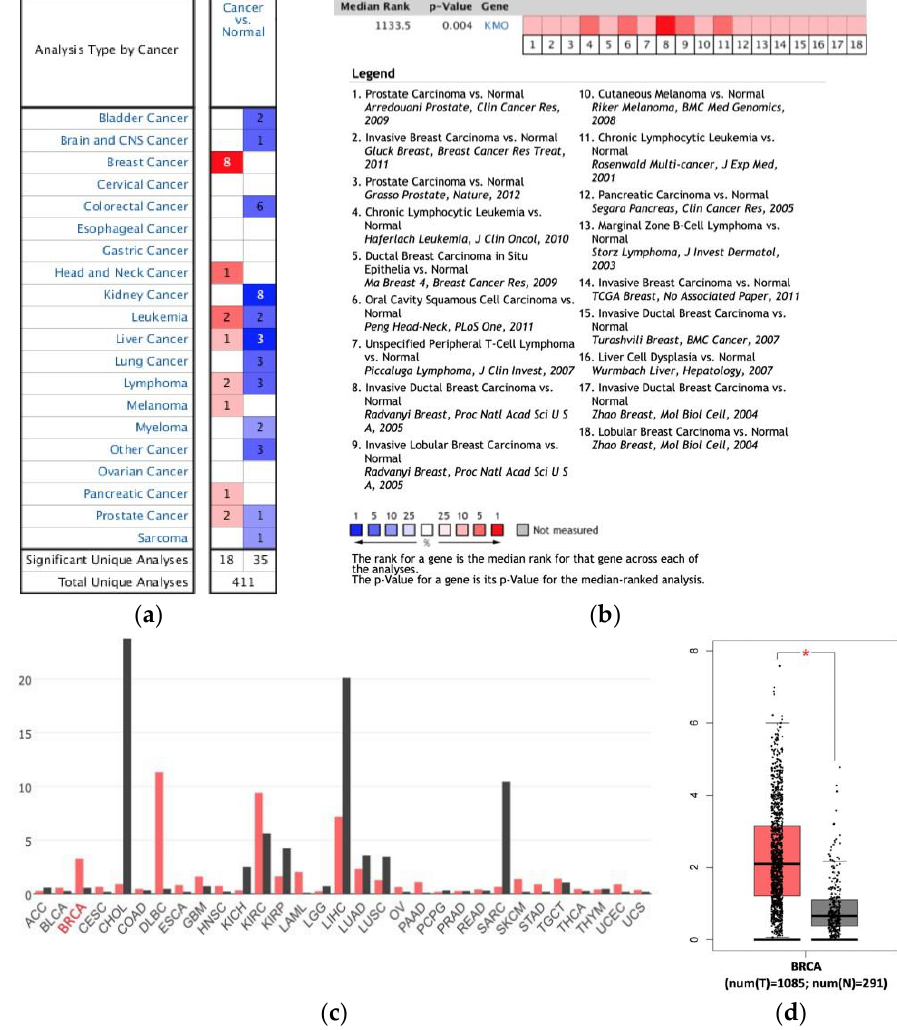
Figure 1. The transcription levels of KMO in human breast cancer. ( a ) The number of datasets with statistically significant KMO mRNA (cancer vs. corresponding normal tissue) overexpression (red) or downregulation (blue) in different types of cancers generated by Oncomine; ( b ) comparison of KMO overexpression across 18 datasets; ( c , d ) GEPIA database results revealing that compared with normal breast tissues ( n = 291), the expression of KMO in breast cancer tissue (BRCA) was significantly upregulated ( n = 1085) (*, p < 0.05).